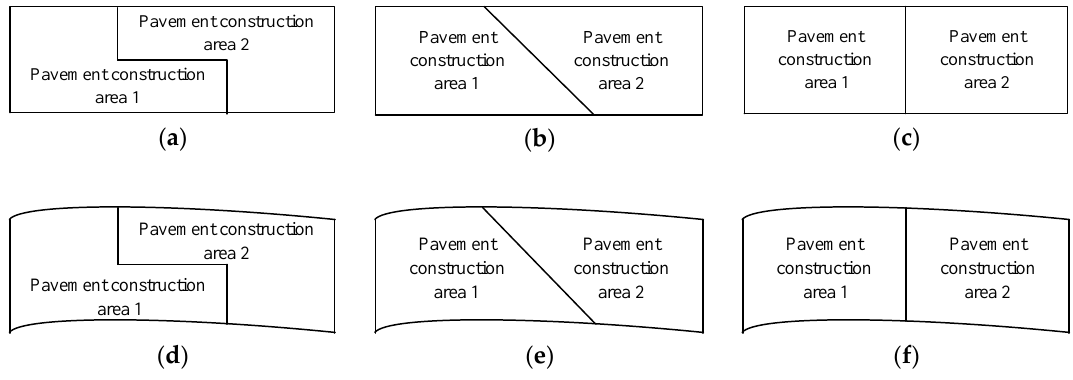
Figure 1. Three types of straight polygon construction joints: ( a ) Stepped seams; ( b ) Miter seams; ( c ) Flat seams, and three types of curved polygon construction joints: ( d ) Stepped seams; ( e ) Miter seams; ( f ) Flat seams.